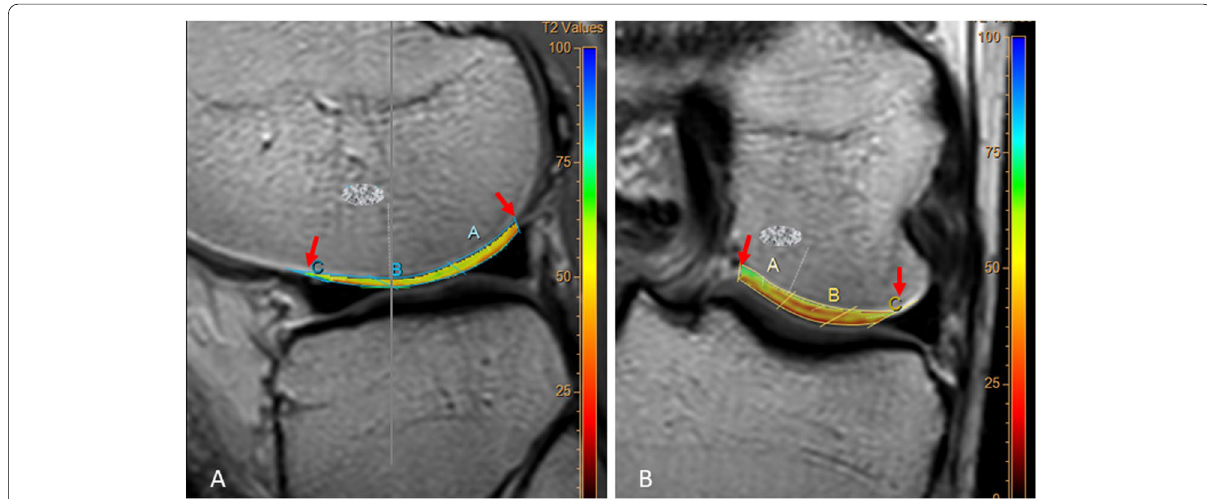
Fig. 2 T2 maps of pre‑defined ROIs (Regions of Interest) of native cartilage. a : (ROI 2) T2 map of the lateral femoral condyle on sagittal plane, between the margins of the posterior and the anterior horns of the meniscus. b : (ROI 4) T2 map of the medial femoral condyle on coronal plane at the level with the highest peak of the intercondylar eminence. The arrows indicate the boundaries of the ROIs. The sub‑regions a , b and c are automatically generated for each ROI